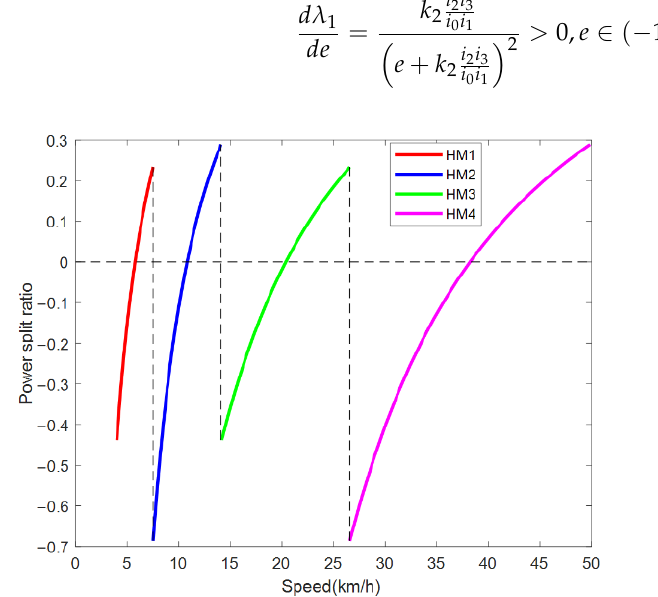
Figure 11. Power split ratio changes with vehicle speed.